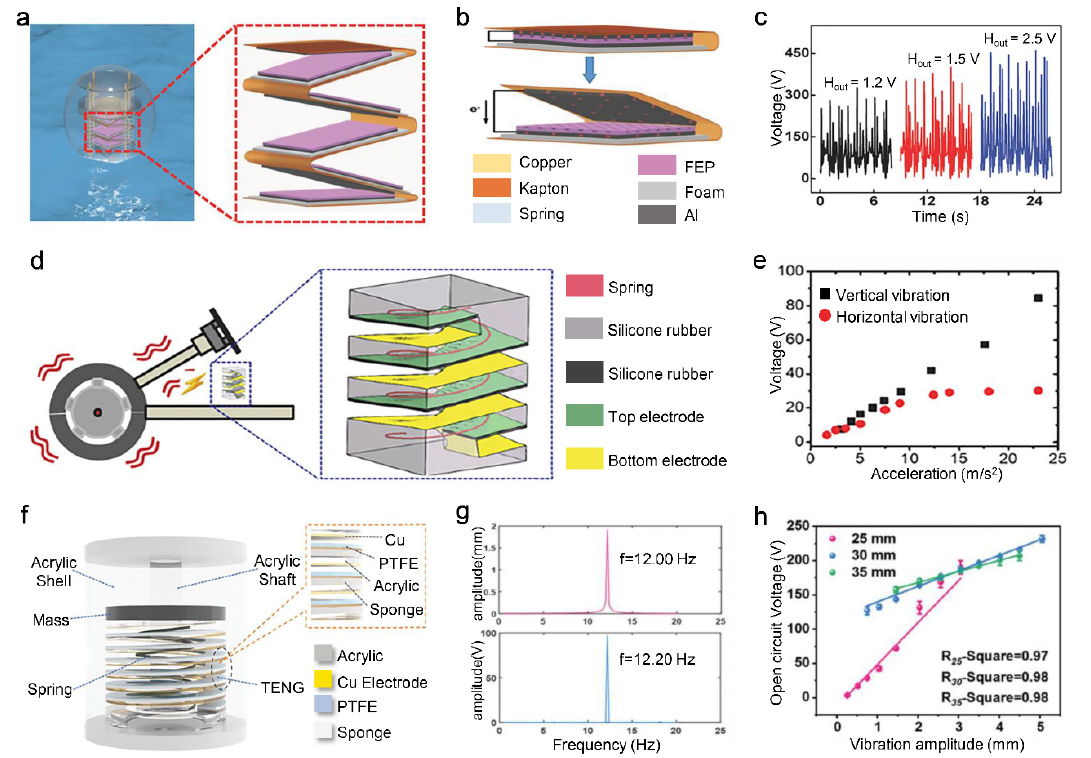
Figure 5. The spring-assisted vibration sensor. ( a ) Schematic diagram of a spring-assisted spherical TENG floating on water. ( b ) Working mechanism of each TENG unit of spherical TENG. ( c ) Relationship between output voltage and external excitations. Reproduced with permission [91]. Copyright 2018, Wiley-VCH. ( d ) Schematic structure of the spring-based TENG. ( e ) Relationship between output voltage and acceleration of S-Teng under vertical and horizontal vibration excitation. Reproduced with permission [95]. Copyright 2017, Wiley-VCH. ( f ) Schematic illustration of the spring-mass based TENG. ( g ) Vibration amplitude signal of the spring-mass based TENG at different frequency. ( h ) Relationship between voltage signal and vibration amplitude. Reproduced with permission [109]. Copyright 2022, Wiley-VCH.